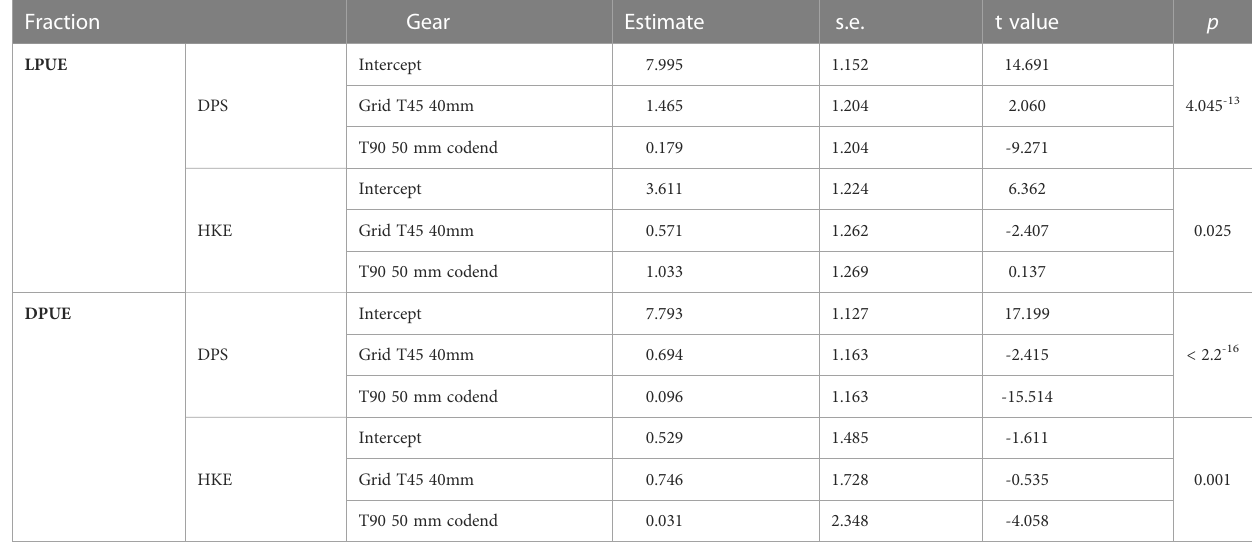
TABLE 2 Coef fi cient estimates for the catch rates of DPS and HKE modelled through linear mixed models in the catch fraction (commercial, LPUE and discard, DPUE). Fraction Gear Estimate